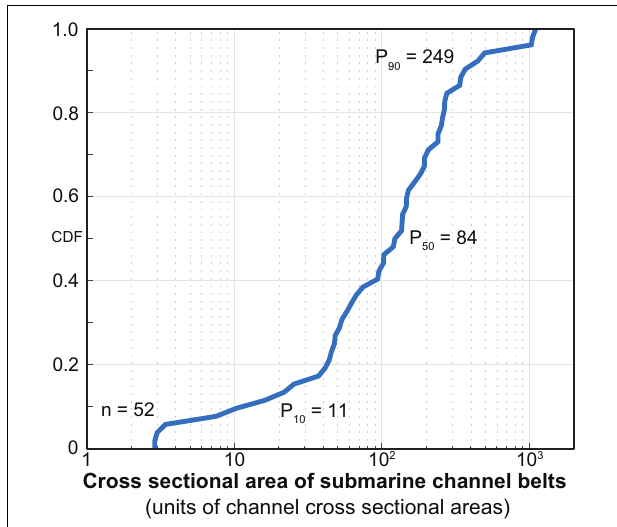
FIGURE 4 | Cross-sectional area of submarine channel belts. These data are derived from cross-sections in Figure 3A , and normalized by the cross-sectional area of the channel in Figure 3B . This data suggests that a typical submarine channel-belt contains ∼ 100 times more sediment than the channel that created